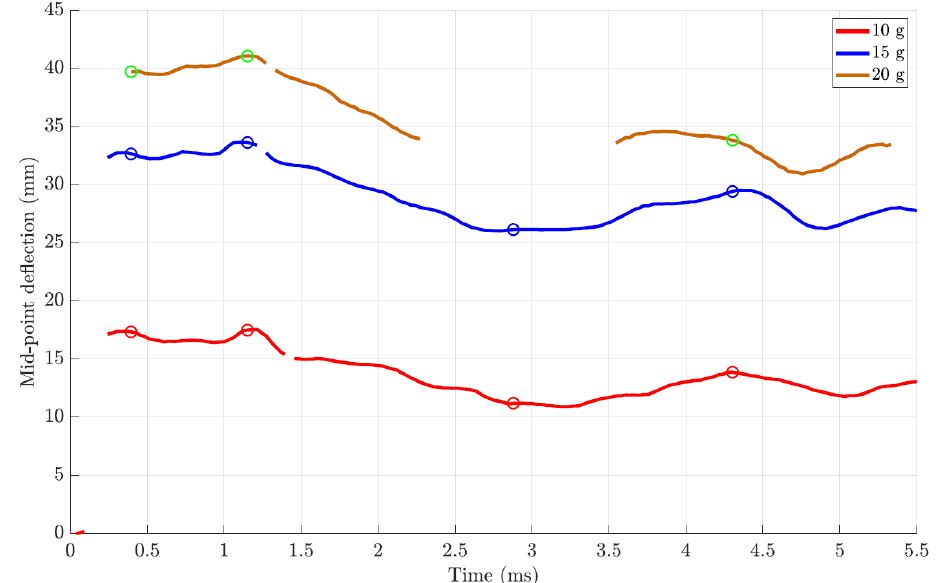
Figure 15. Graph of transient midpoint displacement versus time obtained from the blast tests on 105° V-structures with 62 mm tip radii (circles indicate the discrete times for the selected deformation profiles).